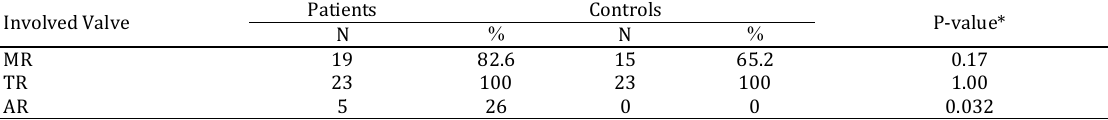
Table 3 . Comparison of Valvular Regurgitation in Participants Involved